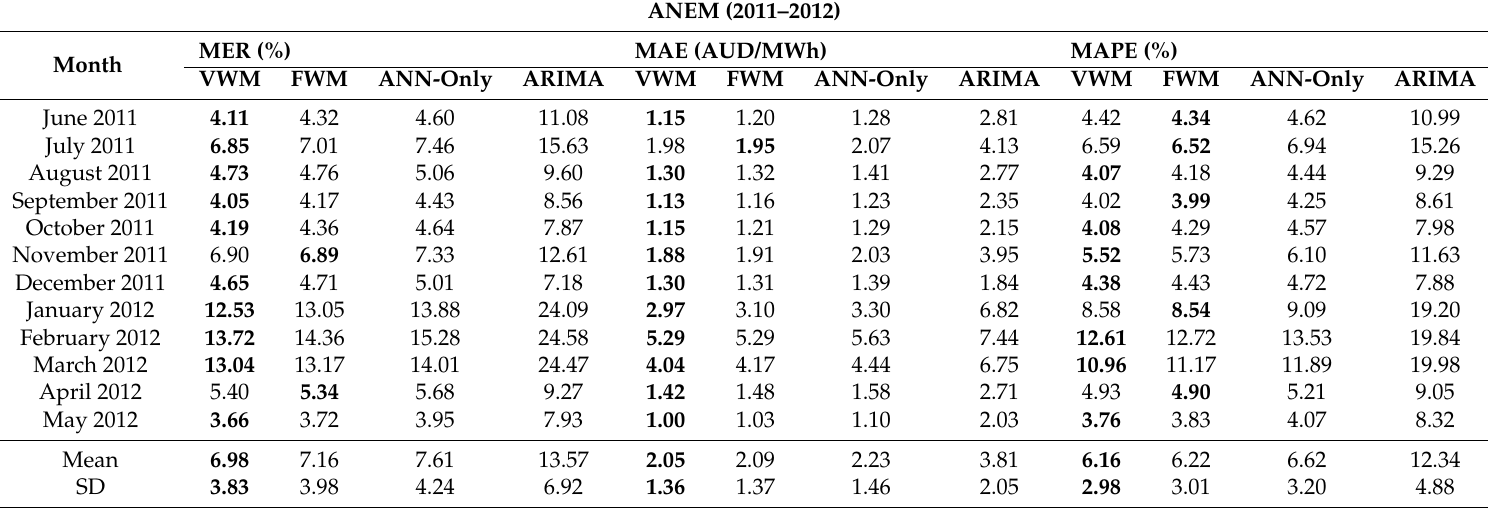
Table 6. MER, MAE and MAPE evaluation metrics for the ANEM market for the years 2011–2012 (Experiment